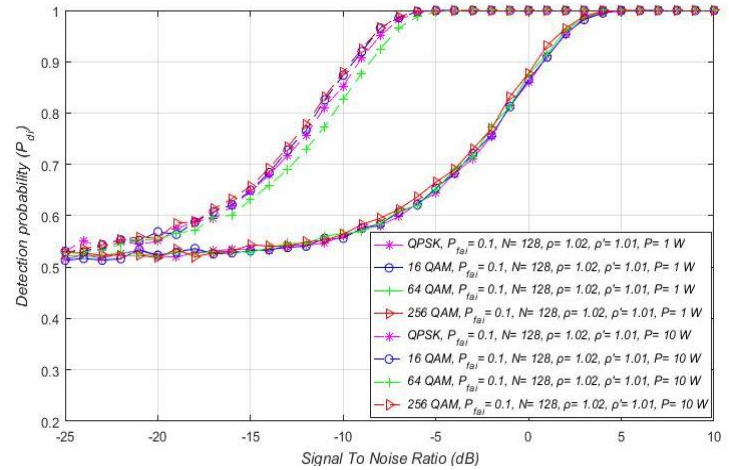
Figure 12. Detection probability vs. SNR for MA system with PU transmitting at distinct Tx powers (1 W/10 W) using four different OFDM modulations.